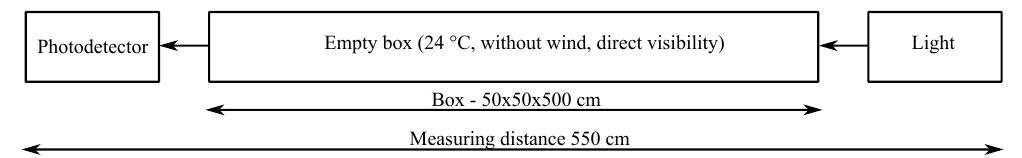
Figure 14. Octavia taillight setup adjusted for scenario 1—empty